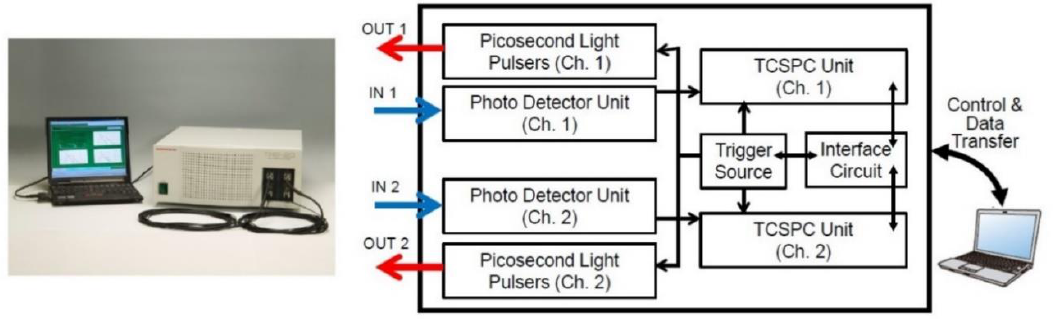
Figure 16. Photograph and schematic diagram of a time-resolved spectroscopy system. Reproduced from reference [14].